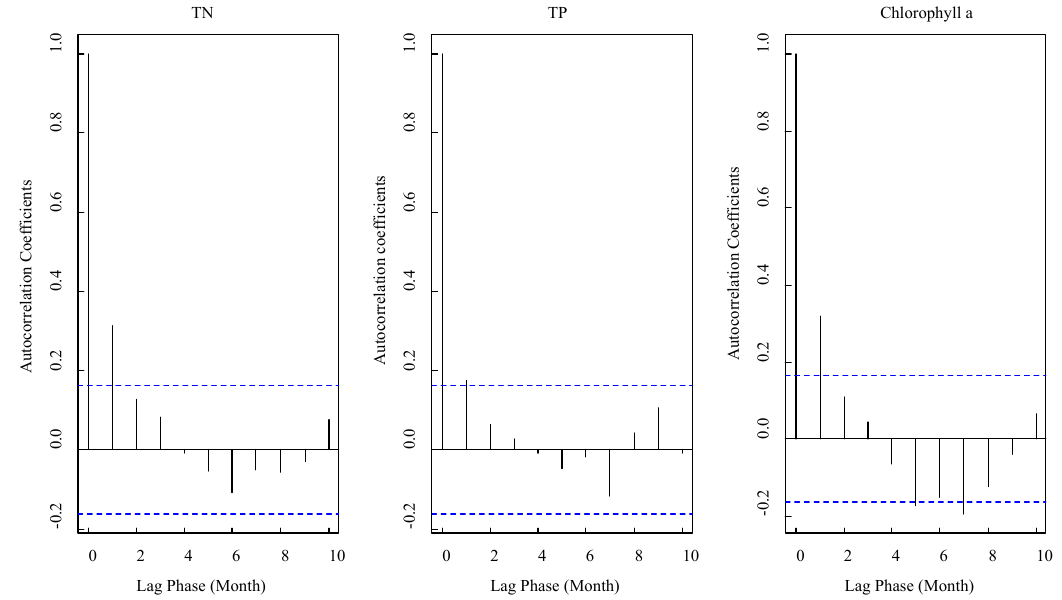
Figure 3. The autoregressive coefficients of TN, TP, and chlorophyll a. The solid lines are the results of the coefficients, the dotted lines show the boundaries of the 95% confidence interval.